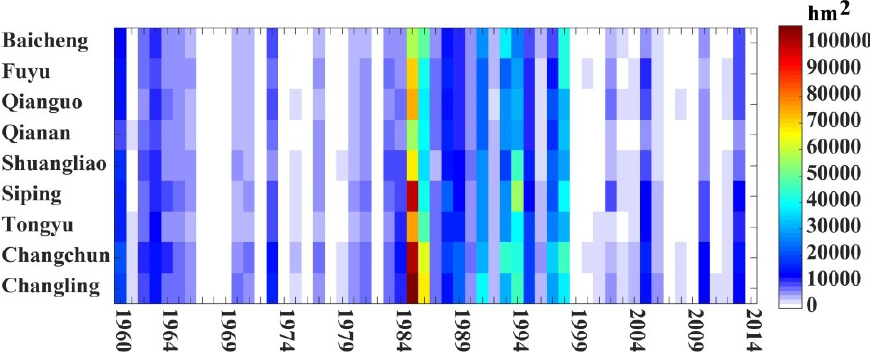
Figure 8. The historical flood-effected area of nine counties in the MJP from 1960 to 2014.